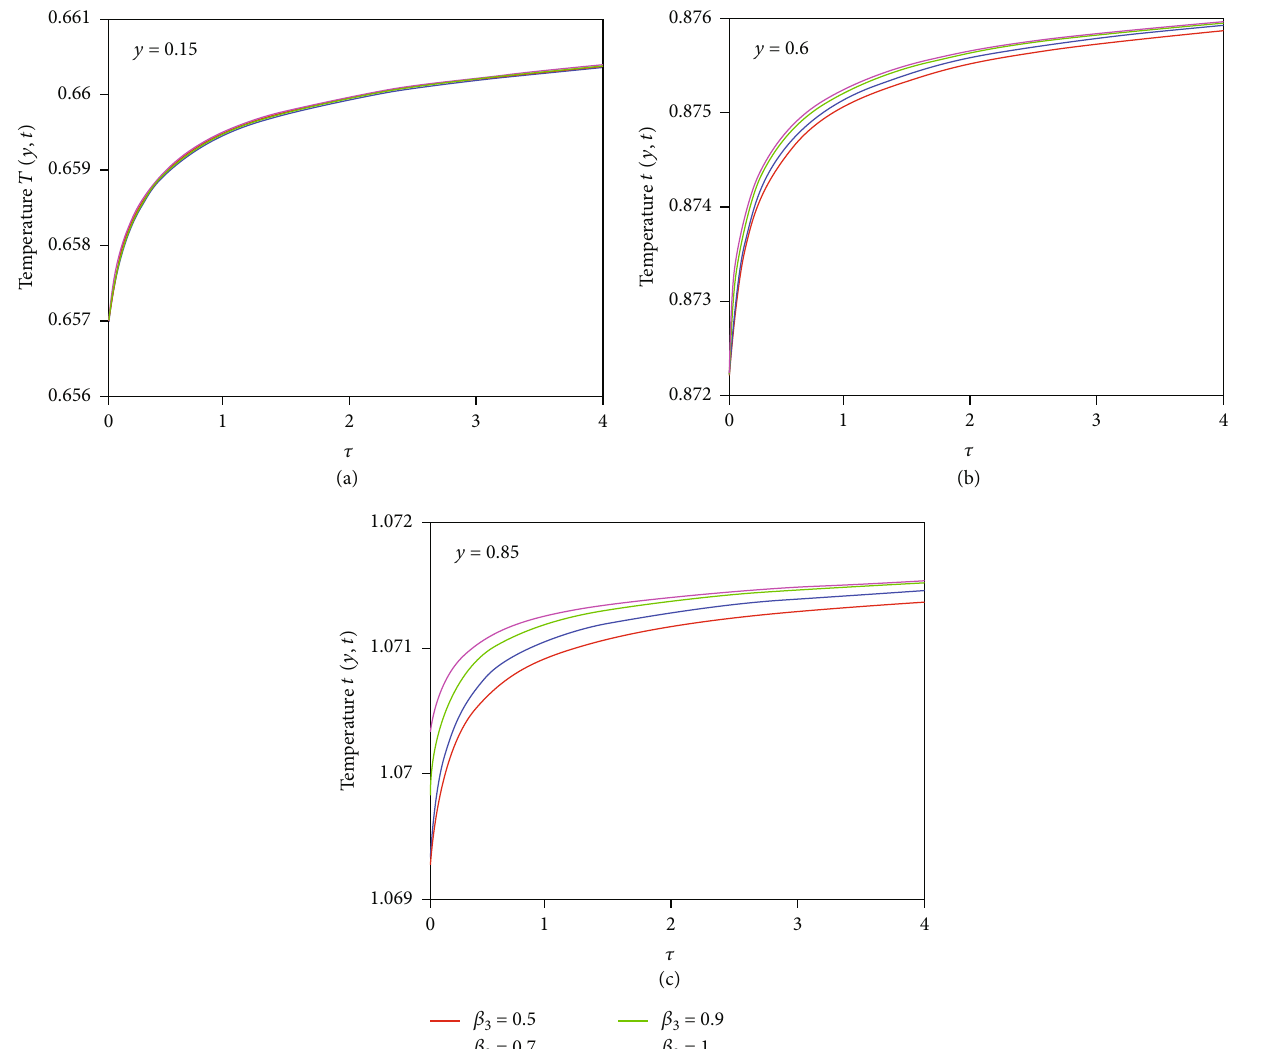
= 0 : 0 : 4 , β = 0 : 6, and di ff erent values of 1 2